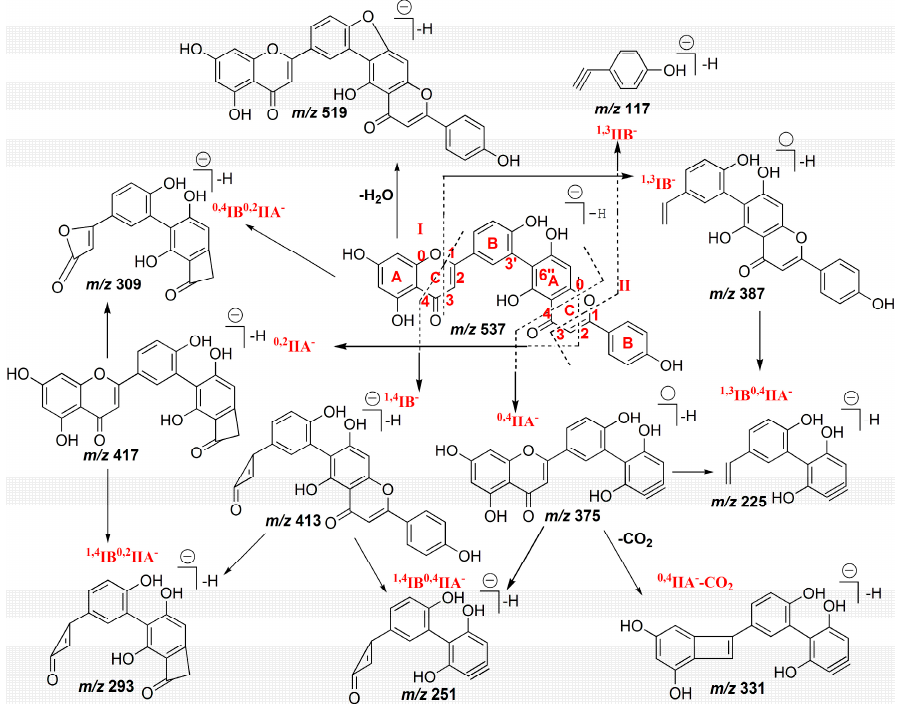
Figure 2. Proposed fragmentation pathway of robustflavone in ( − )ESI mode.